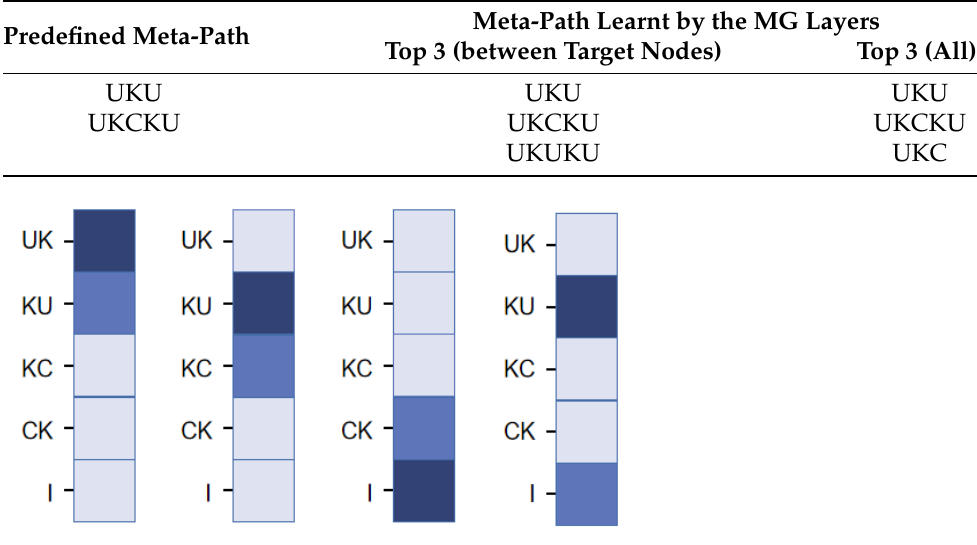
Figure 6. After applying the softmax function on 1 × 1 Conv fillter W i φ (i: Index of the MG layer) in Figure 4, we visualize this attention score of adjacency matrix (edge type) in XuetangX. Each edge indicates (User-Concept), (Concept-User), (Concept-Course), (Course-Concept) and identity matrix. KU, KC is the transpose of UK and CK, respectively. The darker the color, the higher the attention